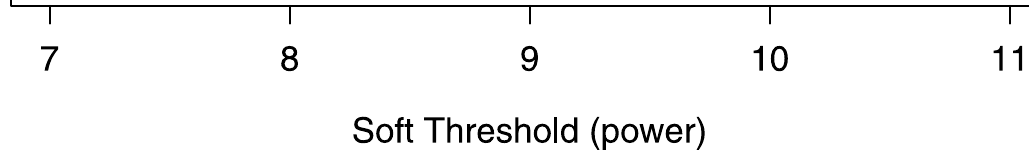
Fig 12. The overlap index between the blue module ( β = 6) and other AD-related modules obtained for different threshold values. We obtained C 0 > 0.75 for all different threshold